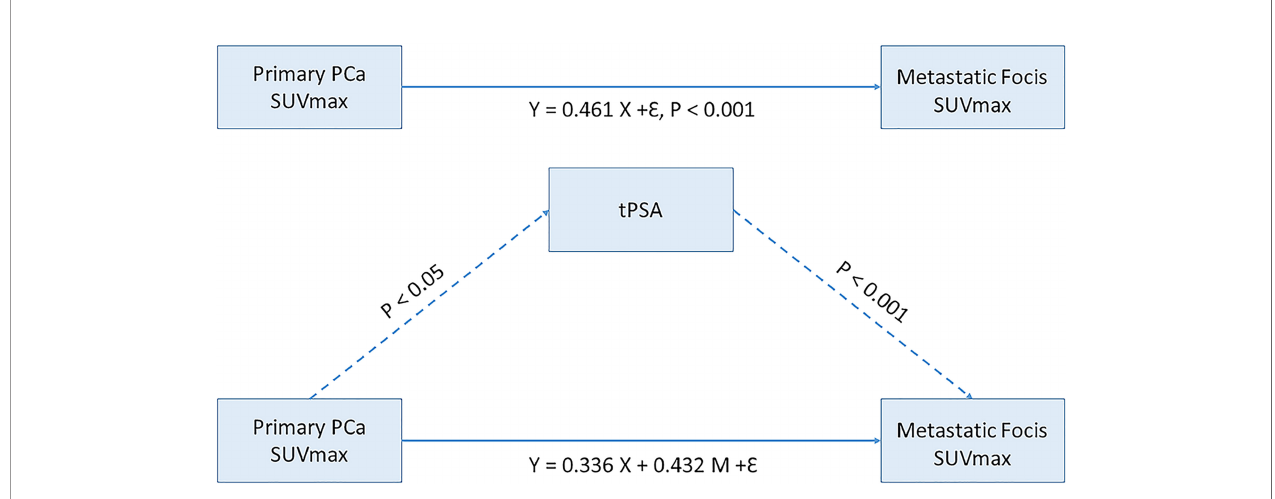
FIGURE 6 | Mediating effect model between primary prostate cancer SUVmax and Metastatic focis. tPSA, total PSA; PCa, prostate